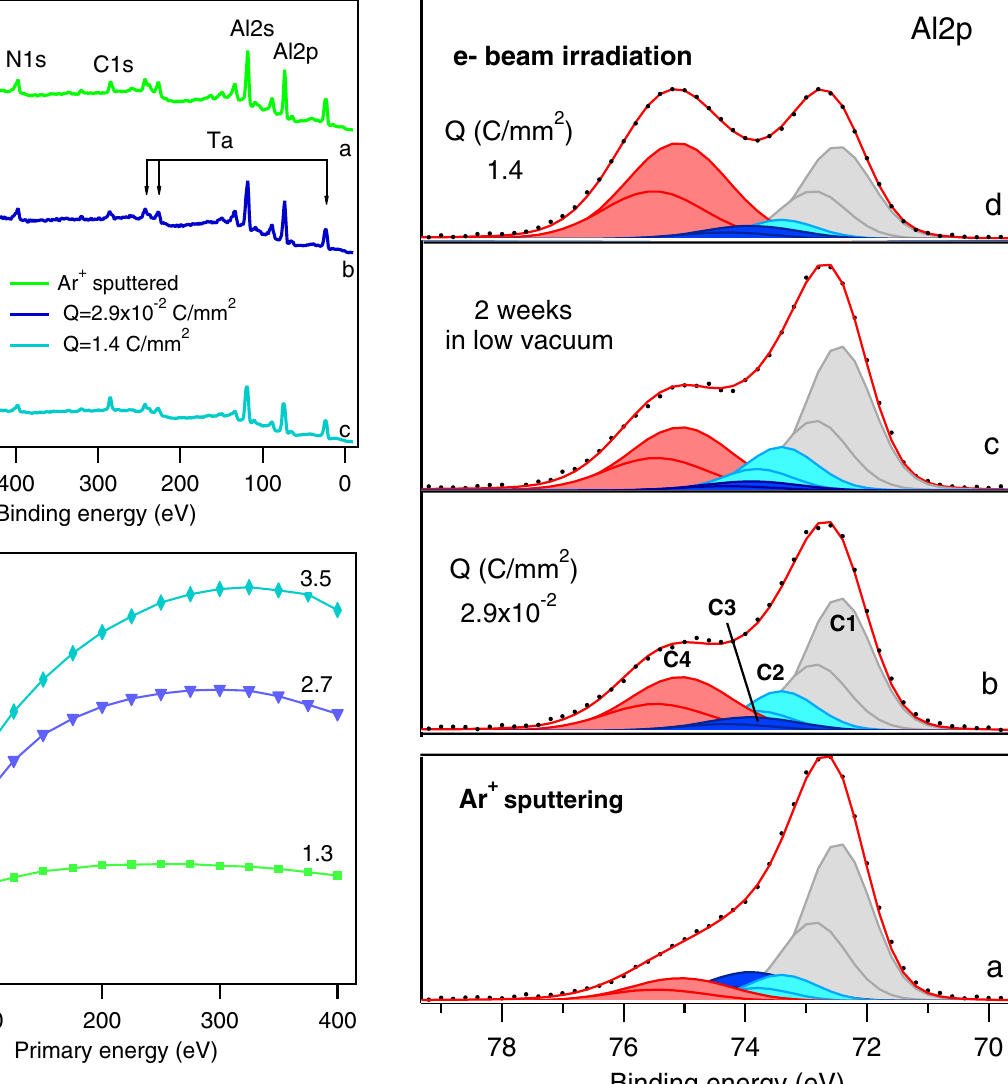
FIG. 5. Top: XPS survey spectra; bottom: SEY curves vs electron beam energy measured on the PETRA III Al sample. FIG. 6. Al2p spectra measured on the Al PETRA III sample (a), (green) after Ar þ bombardment at 2 KeV; (b), (blue) after e (cid:1) (a) after ion sputtering at 2 KeV and after electron beam beam irradiation, 500 eV, 2 : 9 (cid:3) 10 (cid:1) 2 C = mm 2 ; (c), (cyan) after irradiation at 500 eV up to a dose of (b) 2 : 9 (cid:3) 10 (cid:1) 2 C = mm 2 e (cid:1) beam irradiation, 500 eV, 1 : 4 C = mm 2 . The numbers in the and (d) 1 : 4 C = mm 2 . (c) Spectrum taken on the dosed sample (b) value of each bottom panel report the (cid:1) after two weeks of permanence in low vacuum ( 1 (cid:3) 10 (cid:1) 4 mbar ). max The experimental spectra (black circles) are shown together with the best fit curves (red lines) and the C1–C4 doublet components (see text). Spectral decomposition was obtained by considering a spin orbit splitting of 0.4 and a branching ratio of 2 between the 3 = 2 and 1 = 2 doublet components.